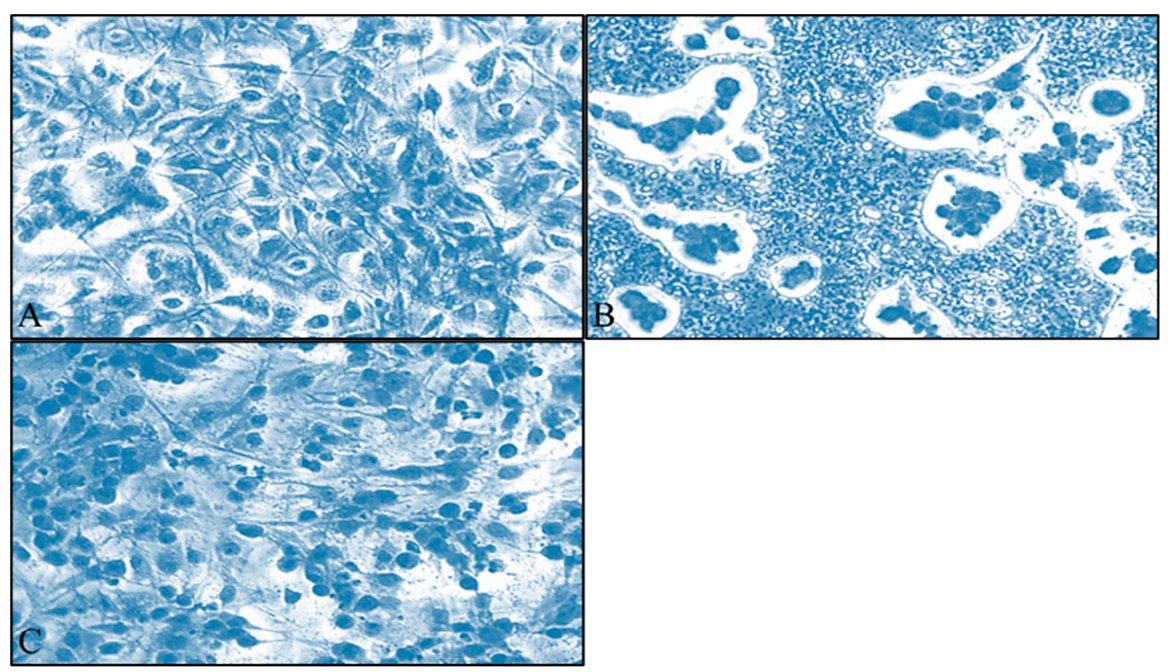
Figure 3. Microscopy inspection of the A172 glioblastoma cells, grown for 72 h in DMEM with no other treatment ( A ), cells treated with 0.78 mg/mL of the extract ( B ) and cells treated with 0.39 mg/mL of the extract ( C ). Images were captured at ×200 magnification. In the case of TE671 cells, the lowest IC 50 was observed at the time point of 72 h and was calculated at 0.629 ± 1.31 mg/mL. The IC 50 values for 24 and 48 h were calculated at 0.820 ± 1.38 mg/mL and 1.044 ± 1.22 mg/mL, respectively (Figure 4A). For the A172 cell line, the lowest IC 50 was calculated at 0.482 ± 0.98 mg/mL 48 h after treatment. The IC 50 values for 24 and 72 h were calculated at 1.061 ± 1.09 mg/mL and 0.749 ± 1.18 mg/mL, respectively (Figure 4B).